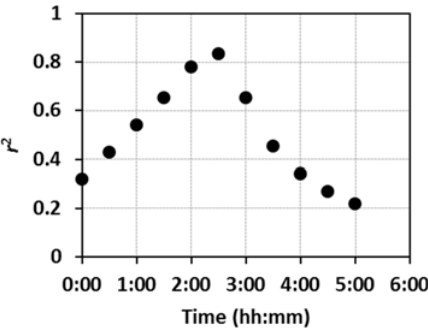
Figure 6. The coefficient of determination, r 2 , between EC evapotranspiration and time-shifted upscaled SF transpiration during the image acquisition day.